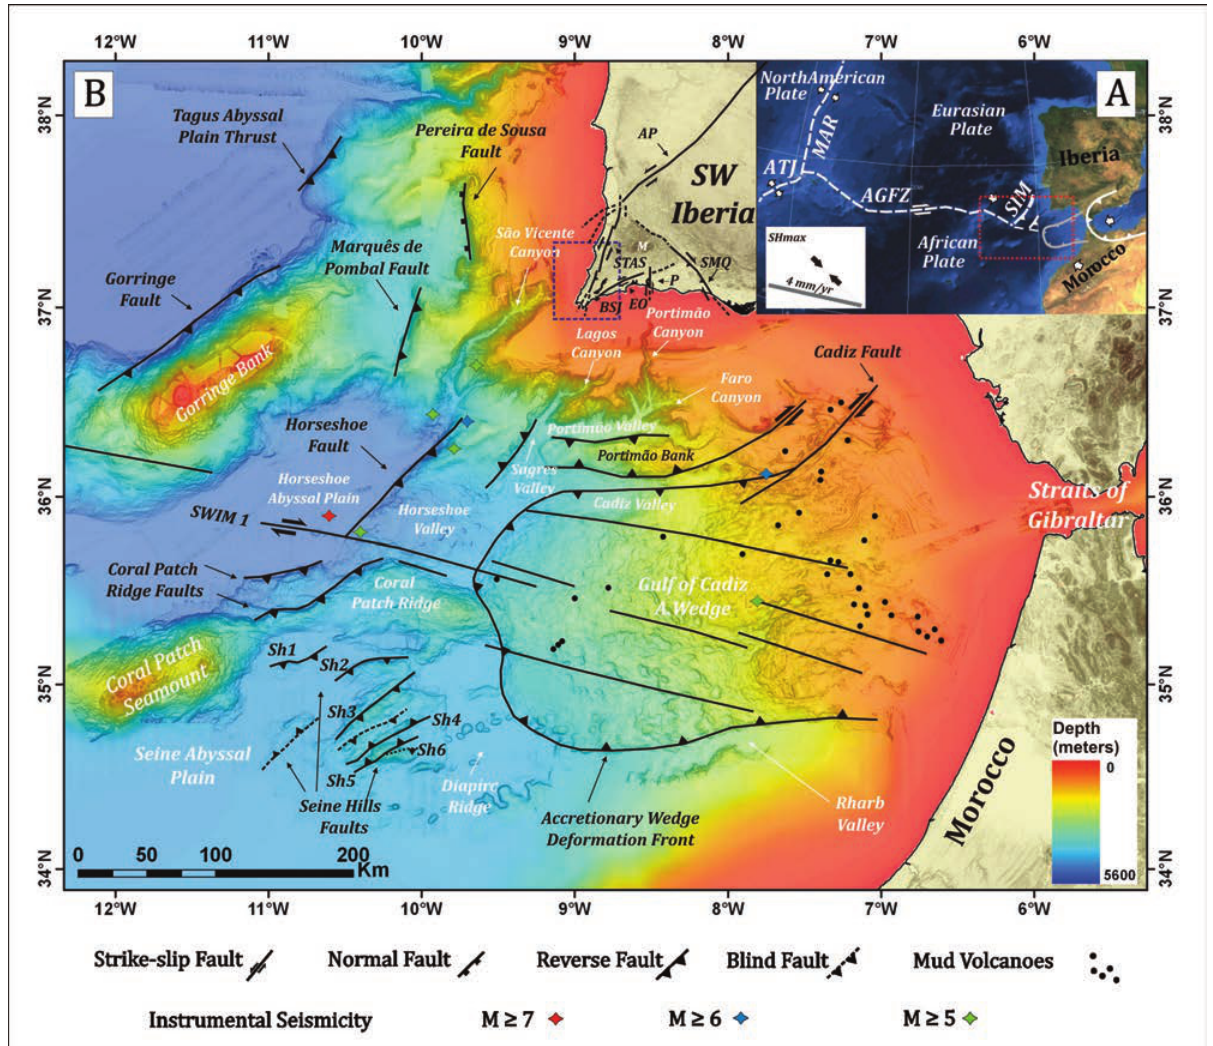
Figure 1. Main active structures and morphological features in the Southwest Iberia region according with Rosas et al. [2012] and Martínez- Loriente et al. [2013] for the offshore and Dias [2001] for the onshore and their localization regarding the Eurasia-Africa plate boundary. (A): Schematic Eurasia- Africa Plate boundary for the region and localization of Figure 1 MAR - Mid - Atlantic Ridge; ATJ- Azores triple Junc- tion; AGFZ-Azores Gloria fault zone; SIM-Southwest Iberian Margin adapted from Duarte et al. [2013], (B) Off-shore structures identified in the map; inland structures: AP-Alentejo-Placencia Fault; STASFS-São Teotónio-Aljezur-Sinceira Fault System; BSJ-Barão de São João Fault; EO-Espiche-Odiáxere Fault; P-Portimão Fault; SMQ-São Marcos-Quarteira Fault. The area studied in this work is delimited by the dashed line adapted from Rosas et al.